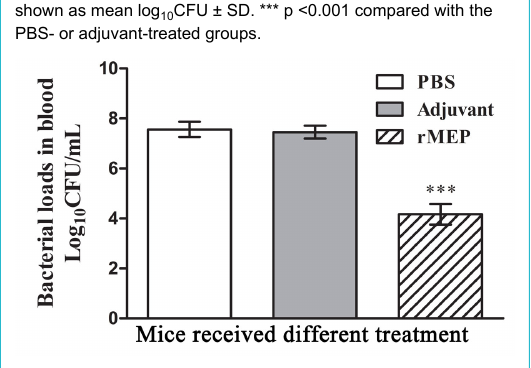
Figure 7: Bacterial loads in the blood of mice 12 hours post- challenge (n = 5) . Blood samples taken from five mice in each group at 12h post-challenge were serially diluted and spread plat- ed on LB agar plates followed by incubation at 37 °C overnight. The number of colony forming units (CFU) was counted, and the log 10 CFU/ml blood was calculated and compared. The data are shown as mean log 10 CFU ± SD. *** p <0.001 compared with the PBS- or adjuvant-treated